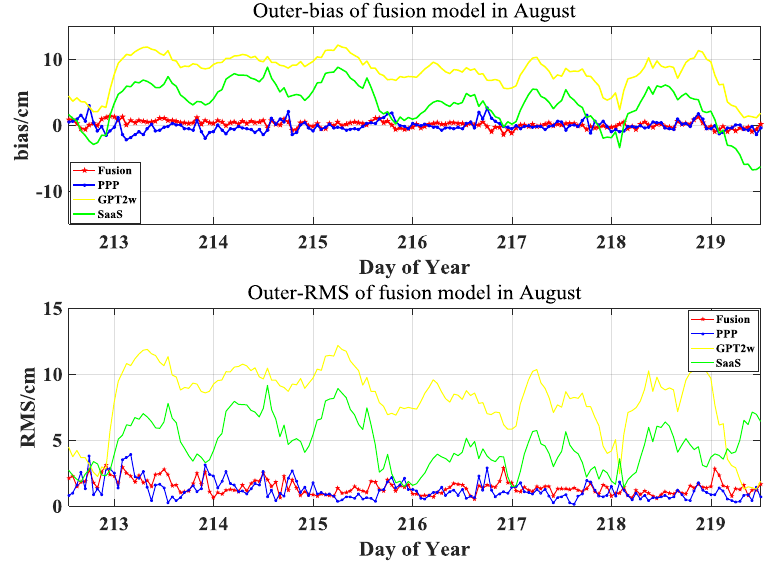
Figure 7. Bias and RMS of each troposphere model in August. Unlike the relatively negative pattern seen in the bias time series on DOY 201~207, an overall positive trend has been identified for the bias time series of the GPT2w and Saastamoinen models during DOY 213~219, which indicates that the empirical and meteorological troposphere delay are overestimated in fair weather. The biases of the SAAS-ZTD values are between -6.76 cm and 8.83 cm, the minimum RMS is 1.41 cm, and the maximum is 9.16 cm. The accuracy of the Saastamoinen tropospheric delay model during the steady troposphere condition is higher than that during the Table 4. Daily mean precision (cm) of troposphere models in August active